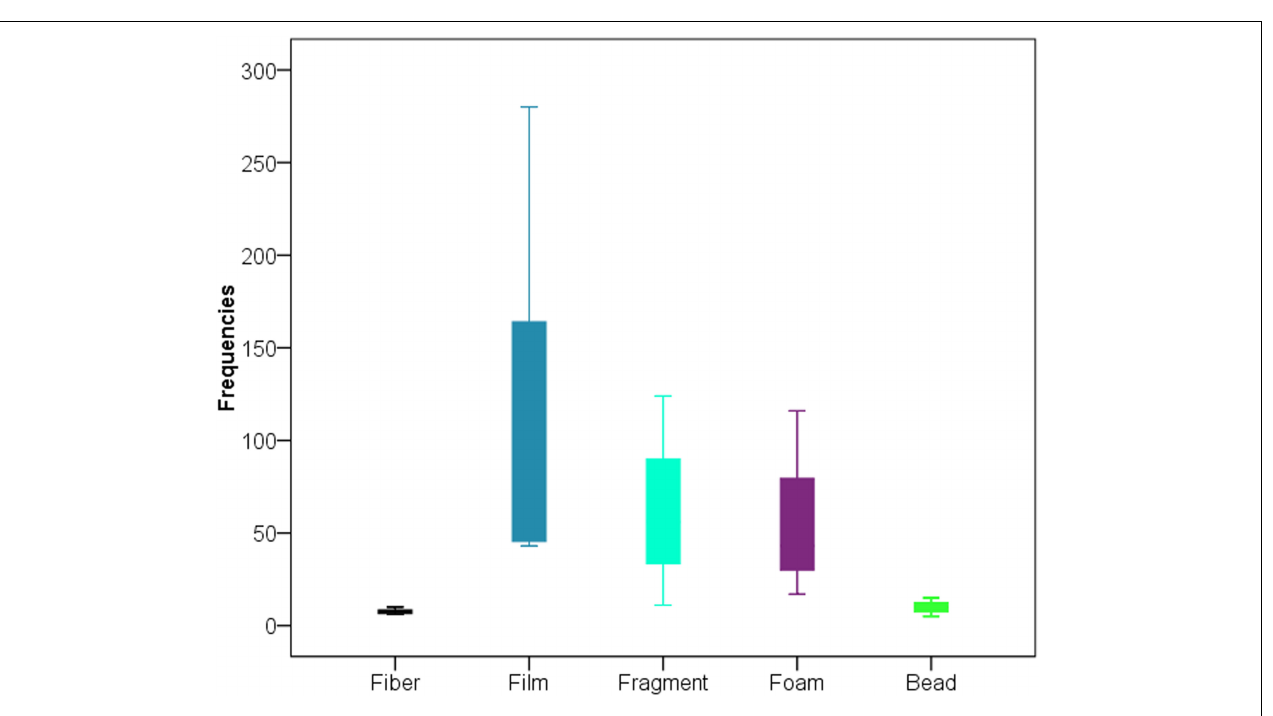
FIGURE 3 | Categorical distribution and frequencies of different forms of MPs identified in GIT of fishes and crab sampled from Karachi coastal